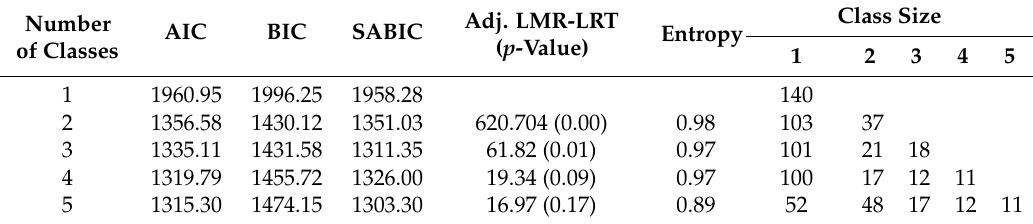
Table 3. Model Fit Indices of Latent Class Analysis and Sample Sizes for 1- to 5-class